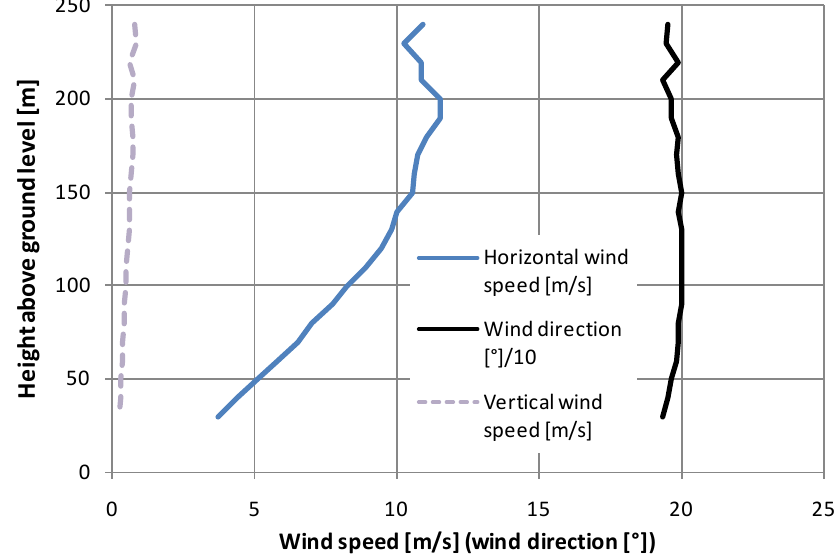
Figure 6. Vertical wind speed and direction profiles as measured with a single frequency three-beam sodar device. Data courtesy of Atmospheric Research and Technology, Inc. [21].